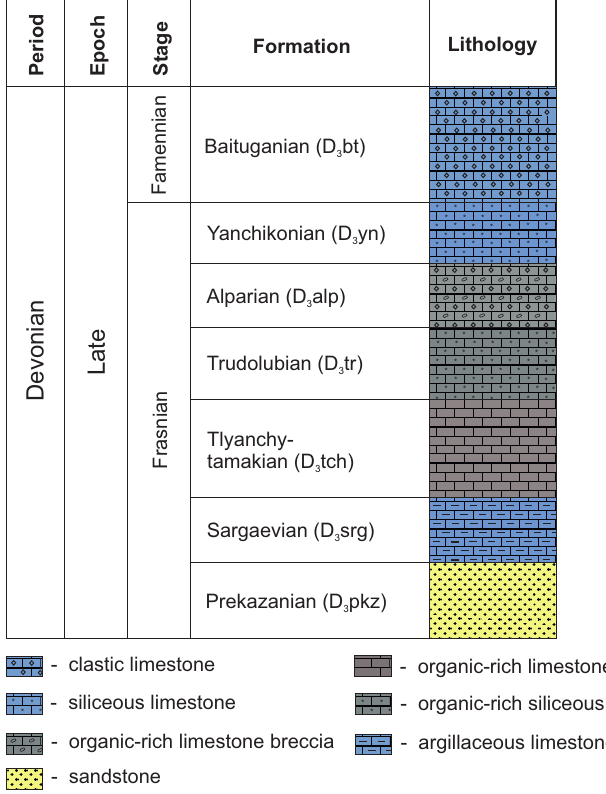
Figure 2. Tlyanchy-Tamakian Formation in the regional stratigraphic